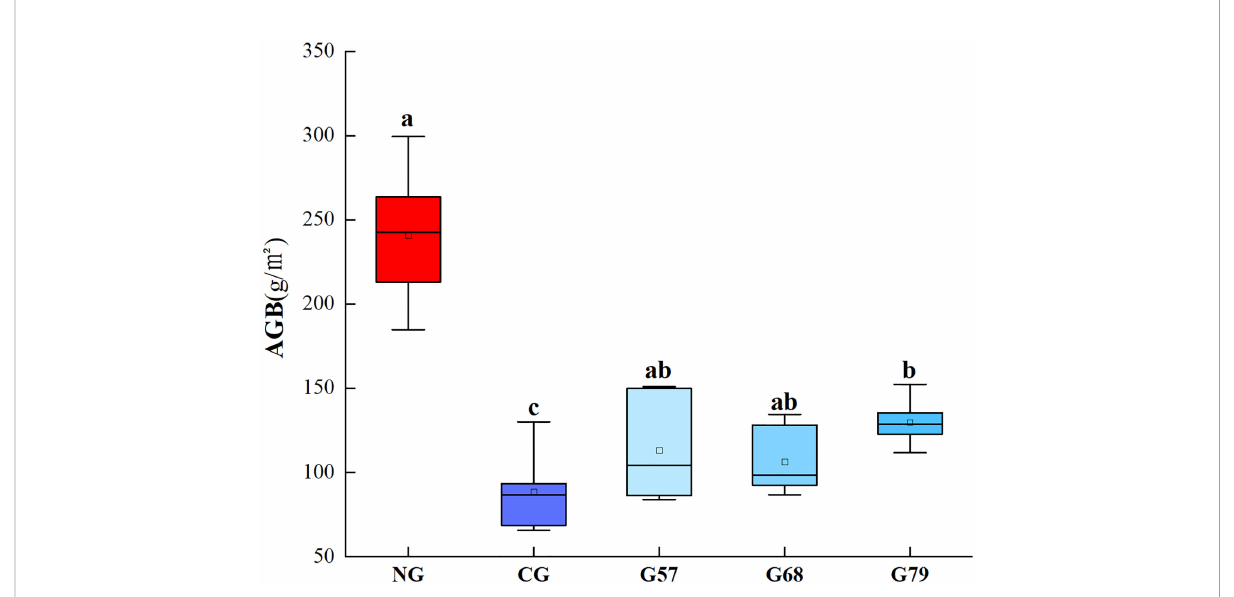
FIGURE 1 Aboveground plant biomass (AGB) in fi ve grassland management treatments. NG: No grazing; CG: Continuous grazing; G57: Grazing in May and July; G68: Grazing in June and August; G79: Grazing in July and September. The error bars in the fi gure represent the standard error, and the lowercase letters represent the signi fi cant differences ( P